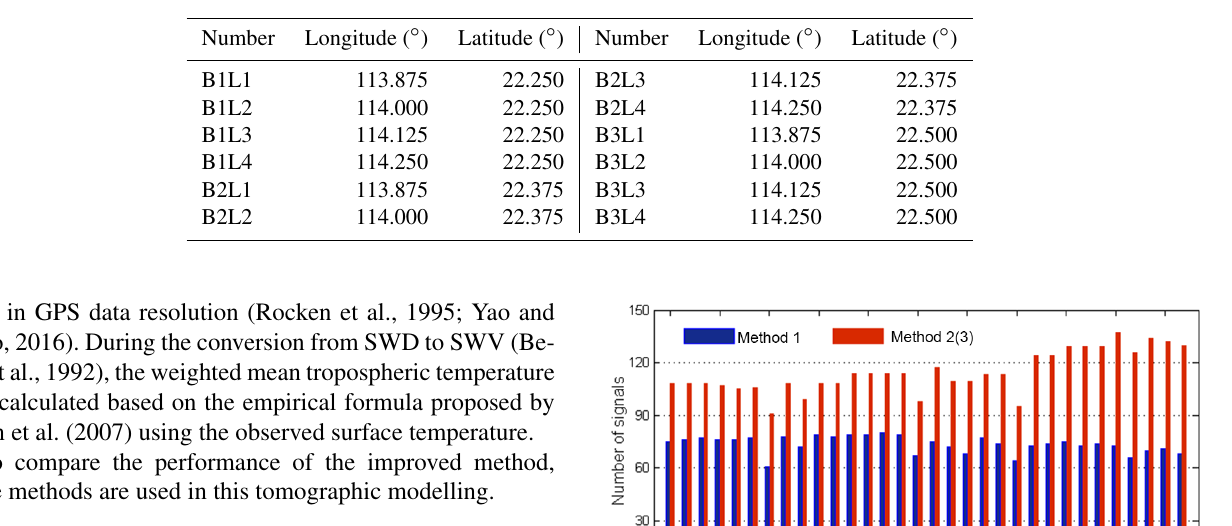
Table 1. Geographic coordination of ECMWF grid points located in the research area.